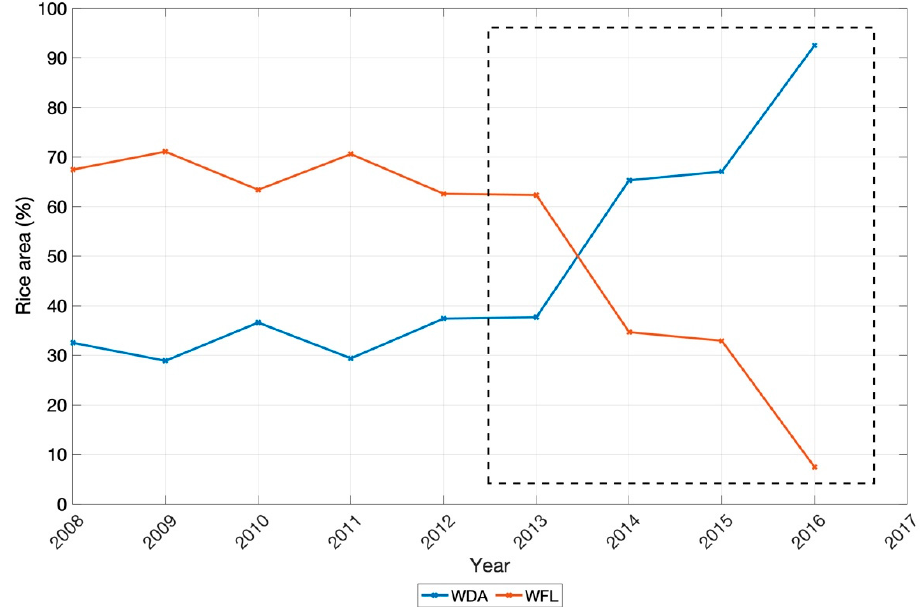
Figure 3. Percentage of rice fields within the whole S. Giorgio district (eastern and western, about 1500 hectares) respectively irrigated by dry seeding (WFL) and intermittent irrigation (WDA) during the period 2008–2016 (Ente Nazionale Risi (ENR) statistics; internal use). The dashed box highlights the four years considered in this study.